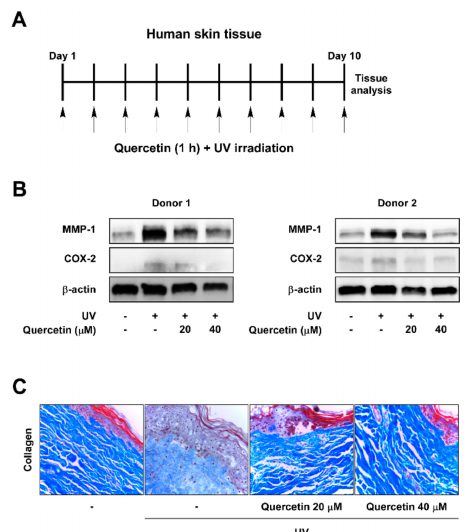
Figure 1. Quercetin suppresses MMP-1 and COX-2 expression and blocks collagen degradation in UV-irradiated human skin tissue. ( A ) Human skin tissue samples were pre-treated with quercetin at the indicated concentrations for 1 h before being exposed to UV (26 kJ / cm 2 ) over 10 days. Skin tissues were subjected to UV at the same time each day. ( B ) Protein expressions of MMP-1, COX-2, and β -actin were determined in human tissue lysate by immunoblot analysis. ( C ) Collagen fibers were detected using Masson’s trichrome